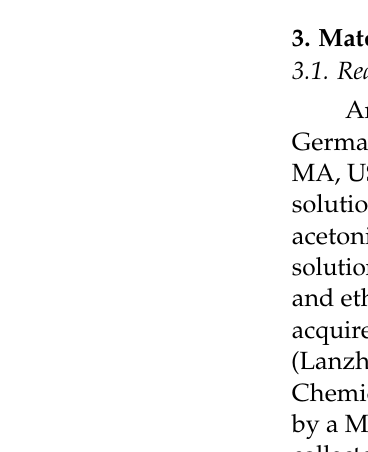
Table 3. Basic information and chromatographic parameters of the analytes.